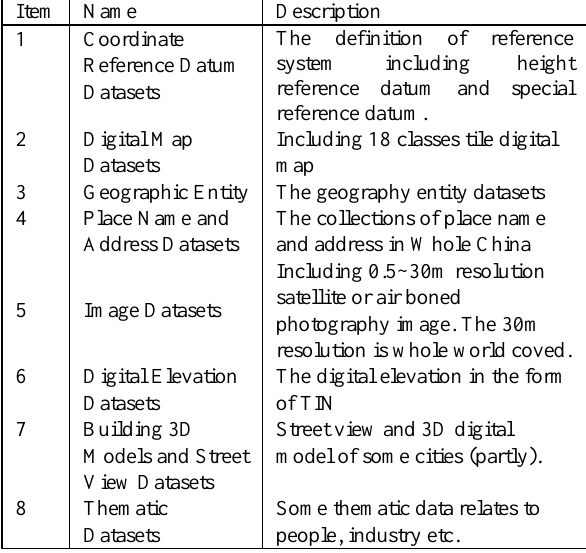
Table 1. Brief view of Chinese NSDI Datasets components The datasets used for the geoportal for public service are eight types: The Coordinate Reference datum, Digital Map Datasets, Geographic Entity, Place name and address datasets, Image datasets, Digital Elevation datasets, Building 3D models and